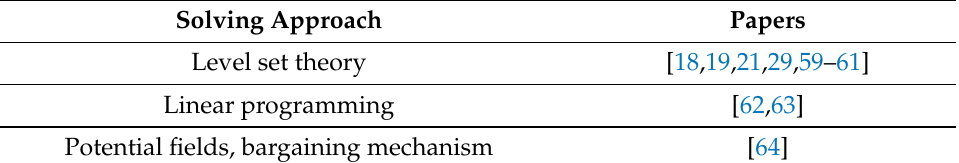
Table 3. Approaches to solving rendezvous games and papers which use